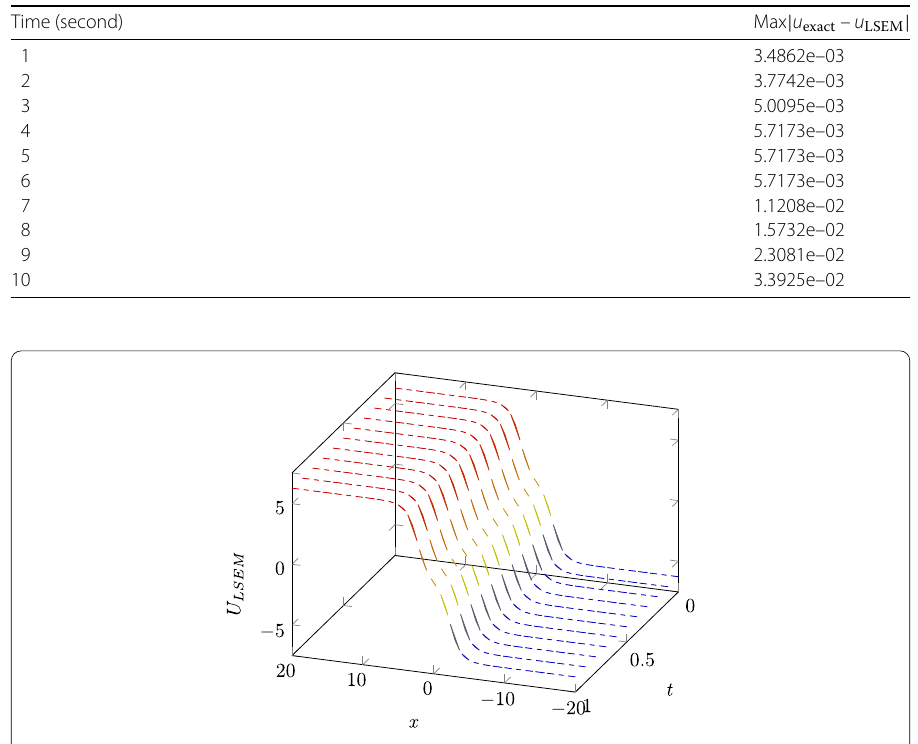
Table 2 Maximum pointwise error at several times for sine-Gordon equation in Example 5.1 with N = 4, N e = 20, and k = 0.01